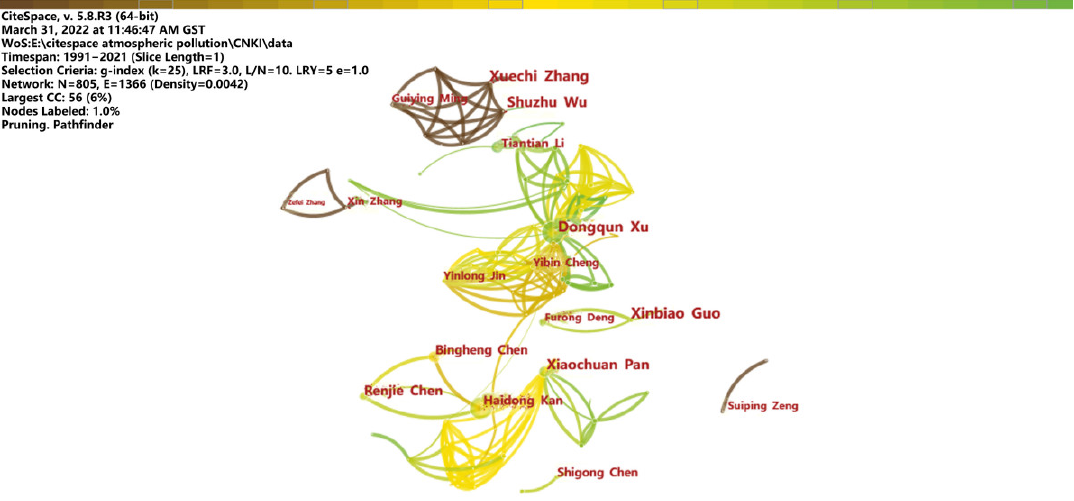
Figure 3. Chinese literature author cooperative network.